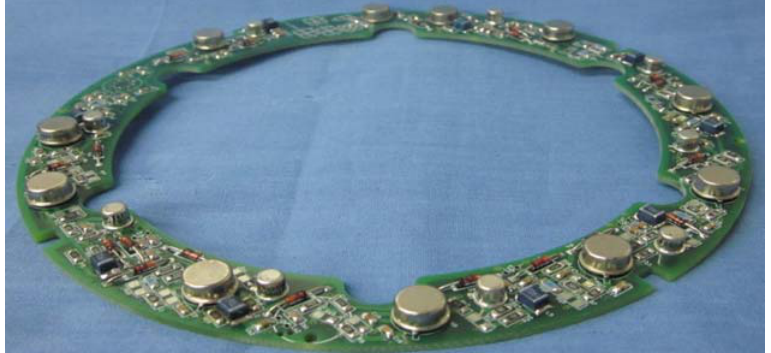
Figure 13. The PCB of the detecting circuits fixed in the frames of the